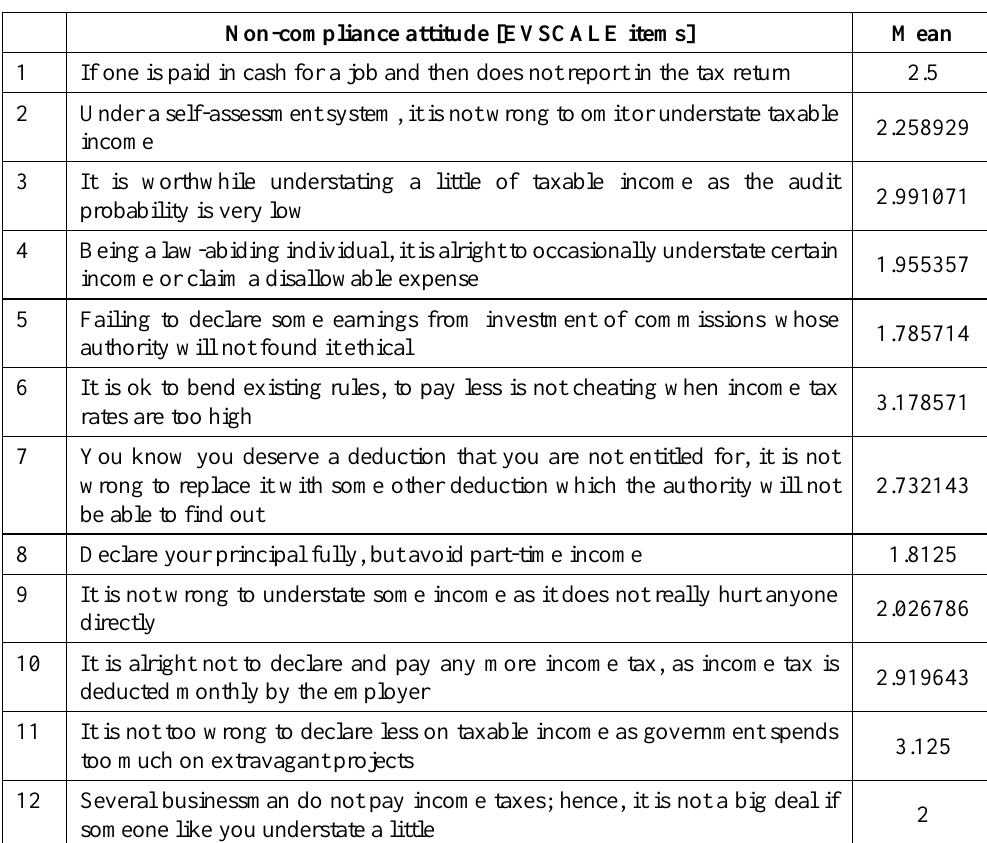
Non-compliance attitude [EVSCALE